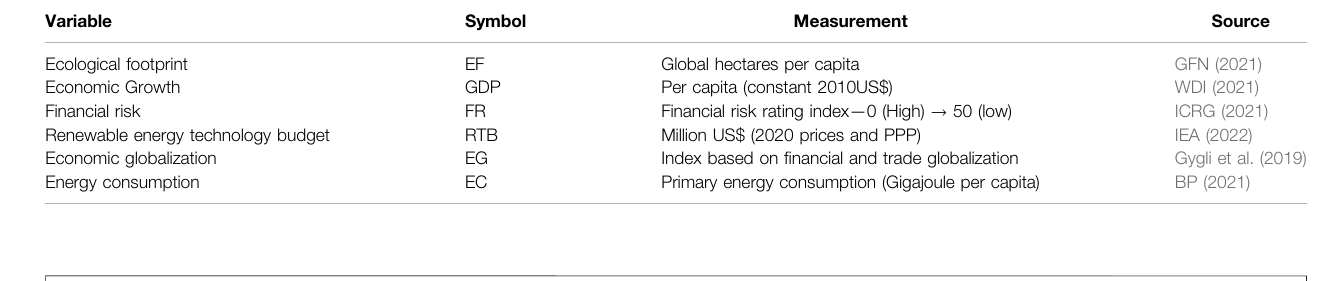
TABLE 1 | Variable ’ s description.